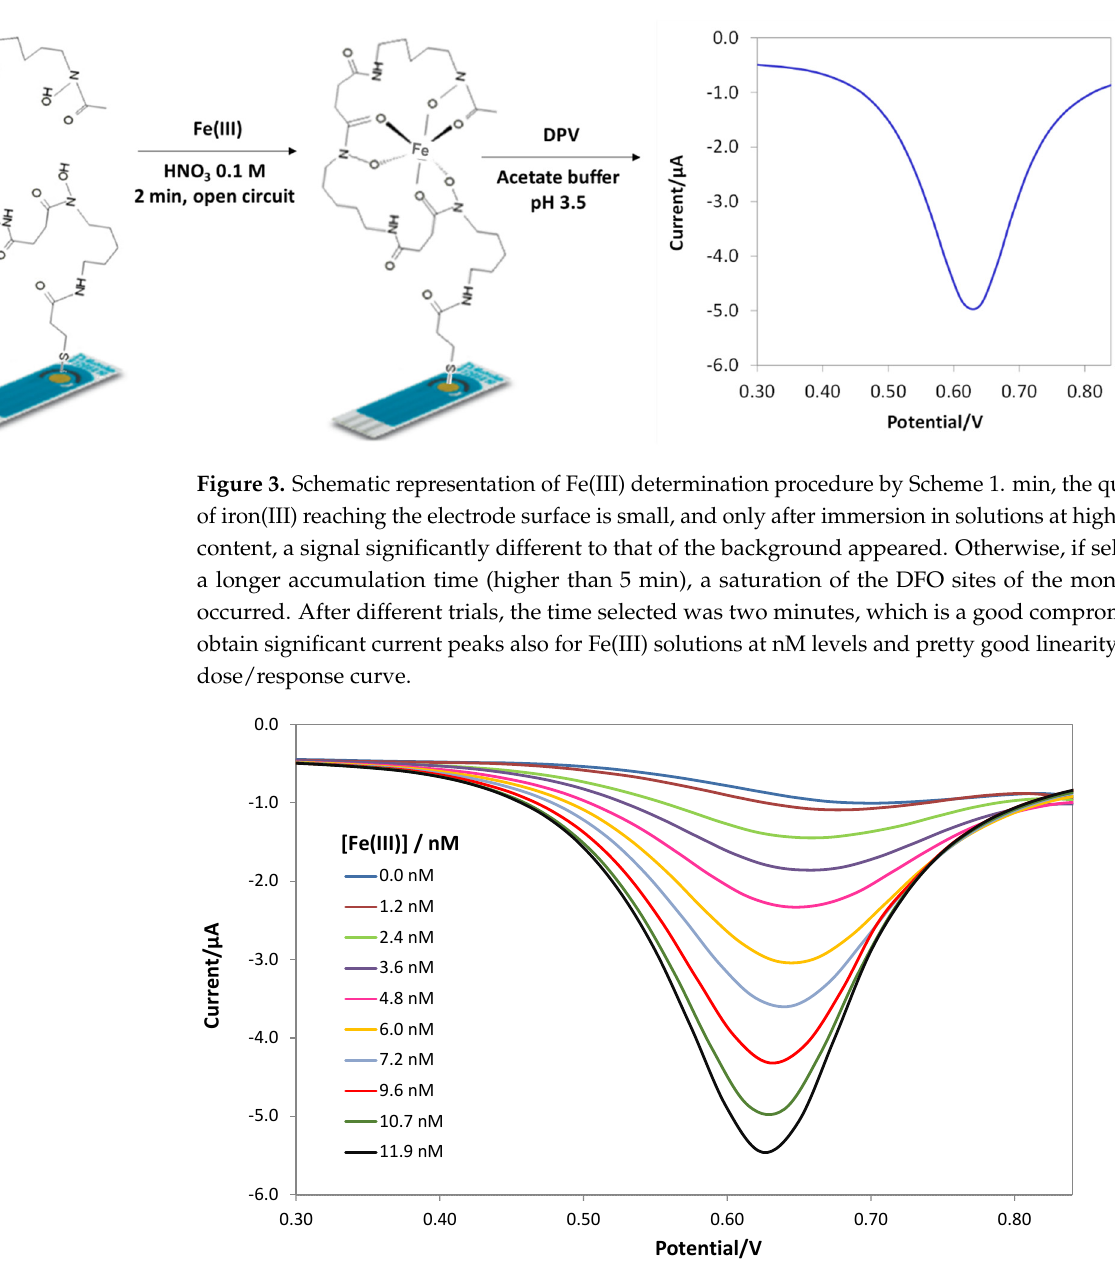
Figure 4. DPV plot obtained on the gold working electrode functionalized with DFO after immersion in Fe(III) standard solutions at pH 1 (from 0 to 12 nM); DPV measurements were performed in 0.1 M acetate buffer at pH 3.5 containing 0.1 M NaClO 4 as a supporting electrolyte. Electrochemical conditions were: start potential +0.9 V, end potential − 0.1 V, scan rate 100 mV/s, pulse amplitude 50 mV, pulse time 0.04